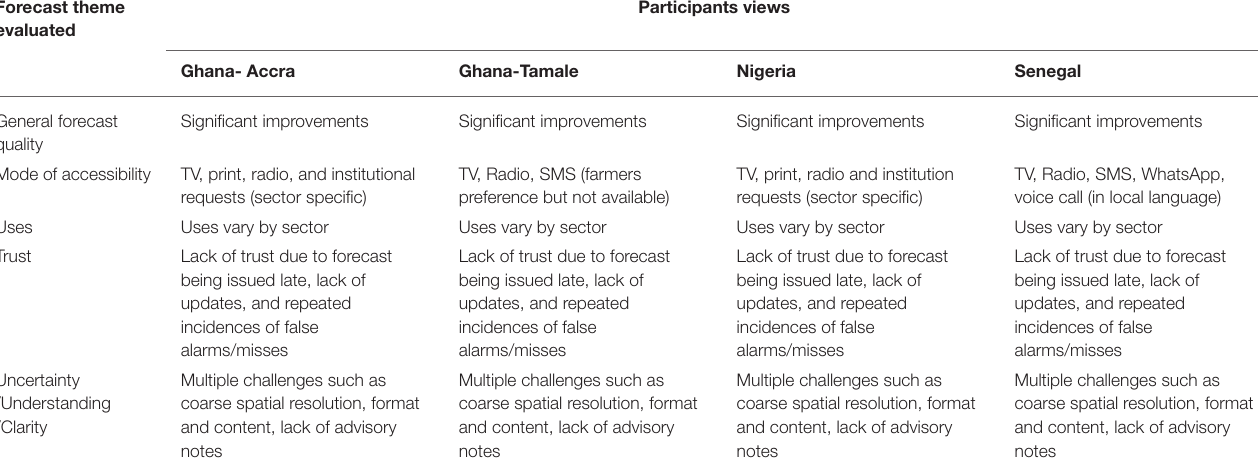
TABLE 2 | Summary of forecast